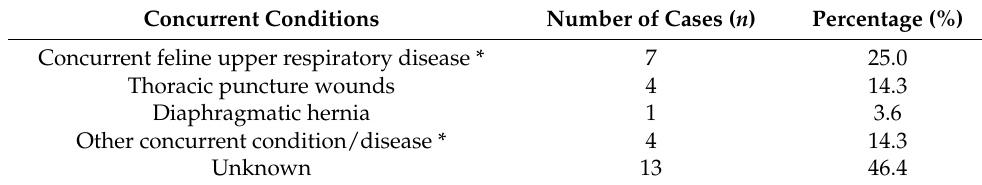
Table 3. Concurrent conditions of pyothorax in 28 cats.